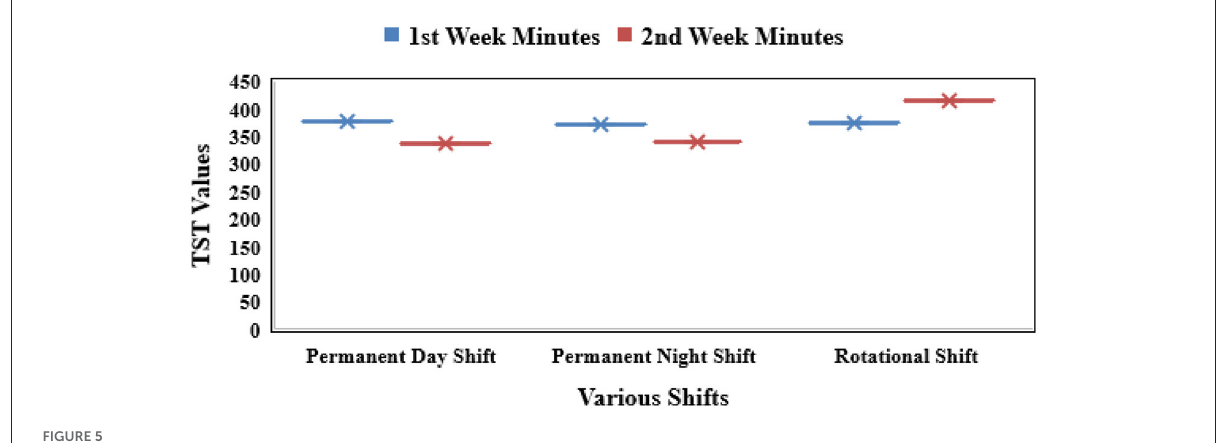
FIGURE5 Comparison of TST values for the various shift laborers.